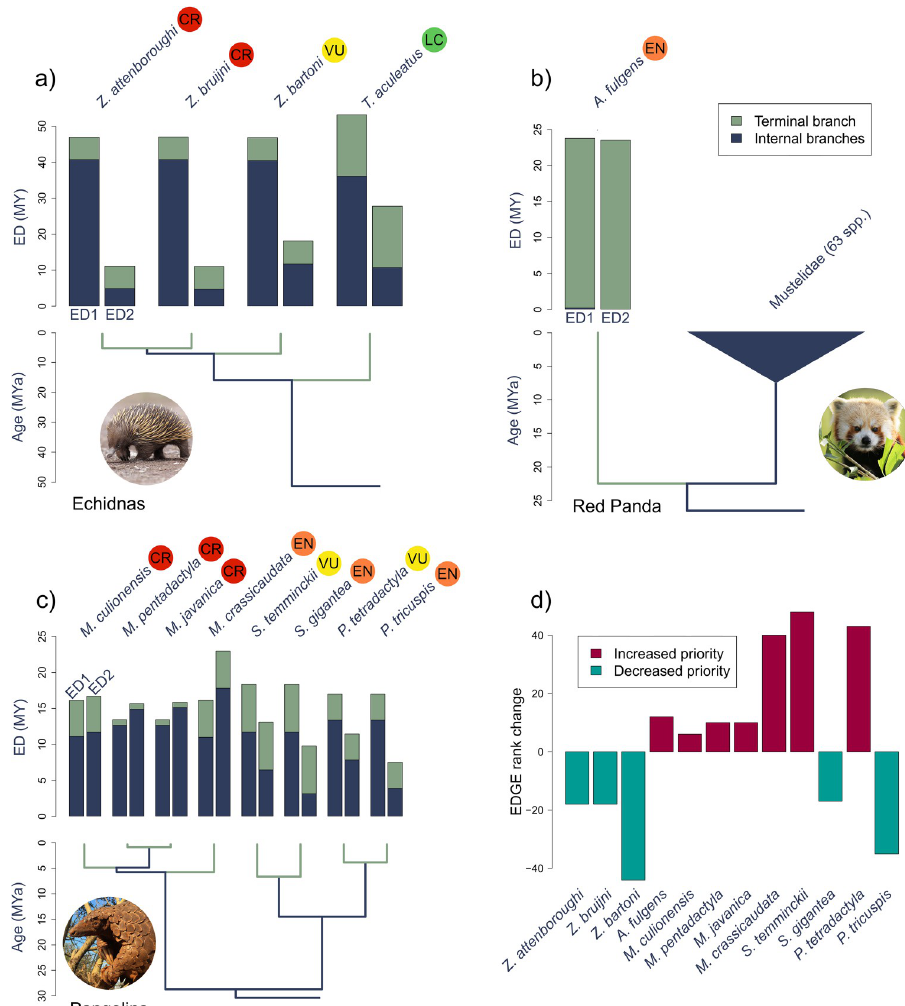
Fig 4. Comparing ED and EDGE scores of priority EDGE species. The change in ED from ED1 to ED2 for ( a ) echidnas (Tachyglossidae); ( b ) the Red Panda ( Ailurus fulgens ); ( c ) pangolins (order Pholidota); and ( d ) the change in priority rank of these species from EDGE1 to EDGE2. The data underlying this Figure can be found in S2 Data. Image credits : echidna : Leo Berzins; Red Panda : Zoological Society of London; pangolin : Wendy Panaino . CR, Critically Endangered; ED, evolutionary distinctiveness; EDGE, Evolutionarily Distinct and Globally Endangered; EN, Endangered; LC, Least Concern; VU,